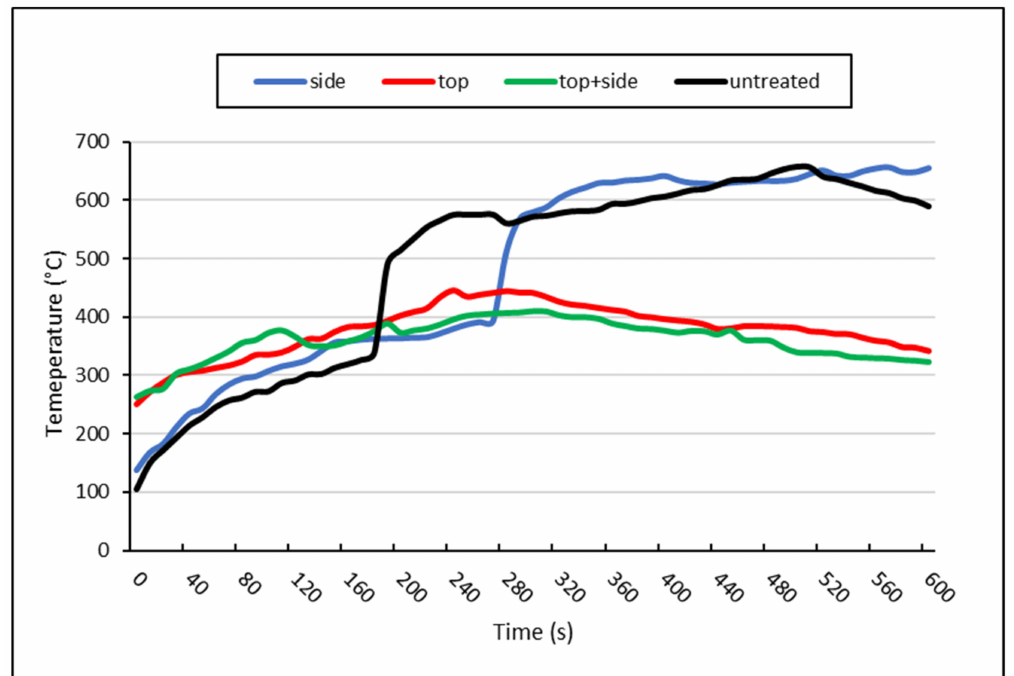
Figure 4. Temperature course of the samples on side